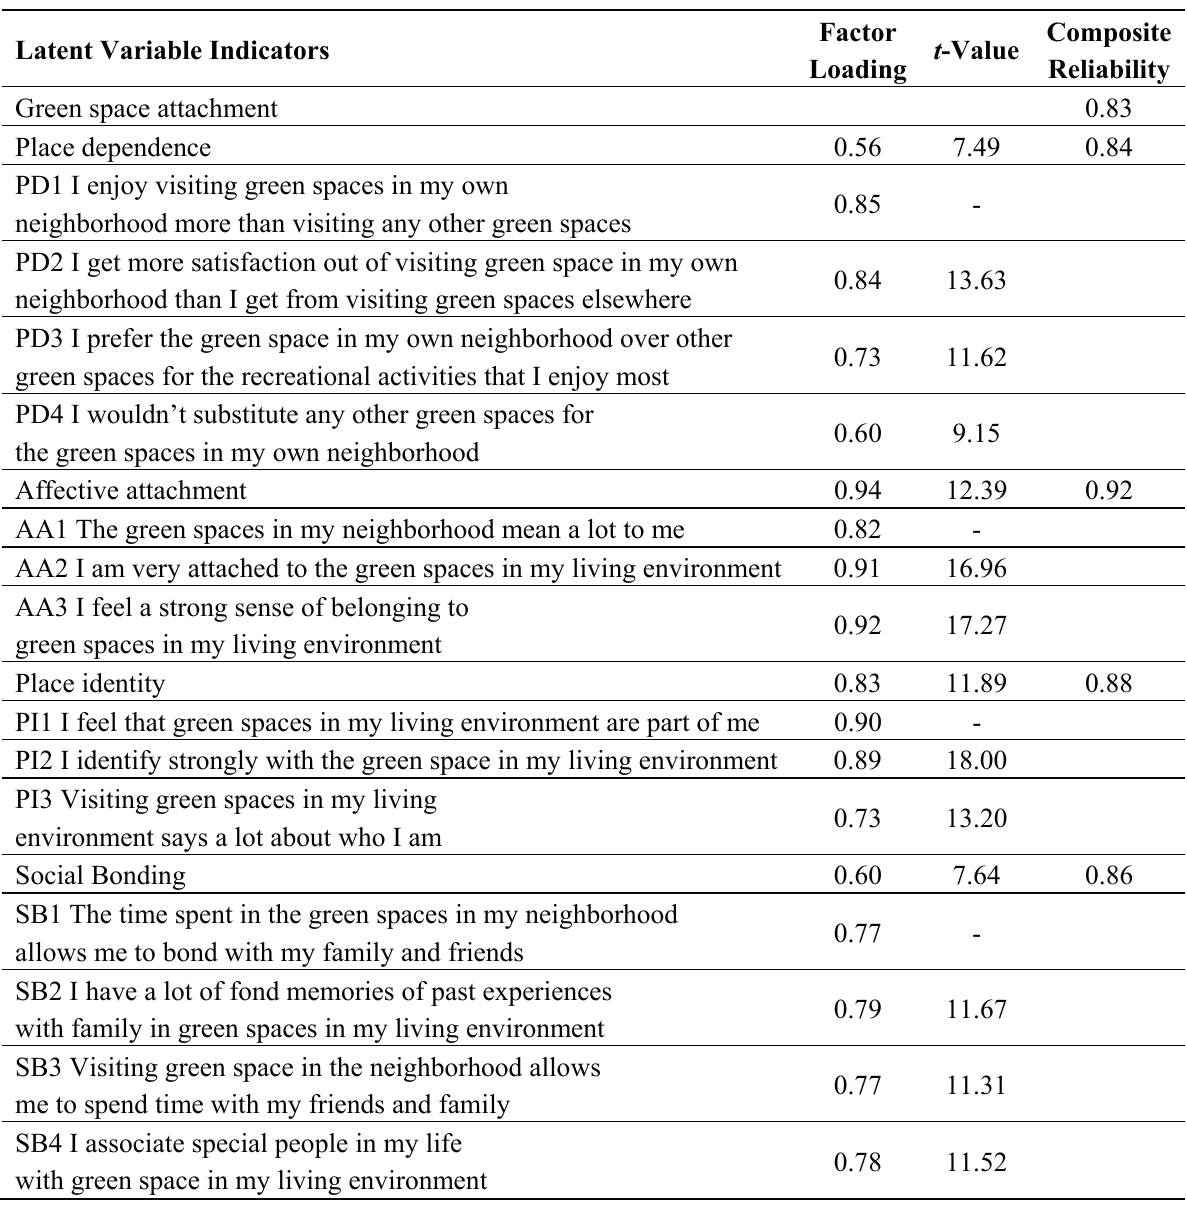
Table 4. Measurement model of second-order factor green space